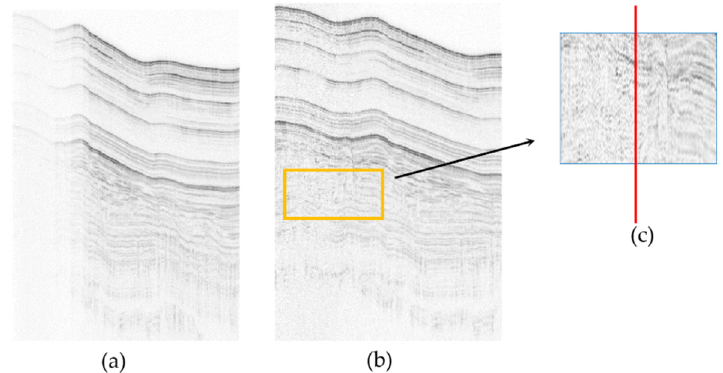
Figure 7. The original SBP image and the SBP image after histogram matching, ( a ) is the original SBP image, ( b ) is the SBP image after grayscale equalization, ( c ) shows details in the area marked with a yellow rectangle in ( b ). ( c ) shows that the rectangle area in ( b ) is separated into two parts having different Signal-to-Noise Ratio (SNR) and the left part has a low SNR.